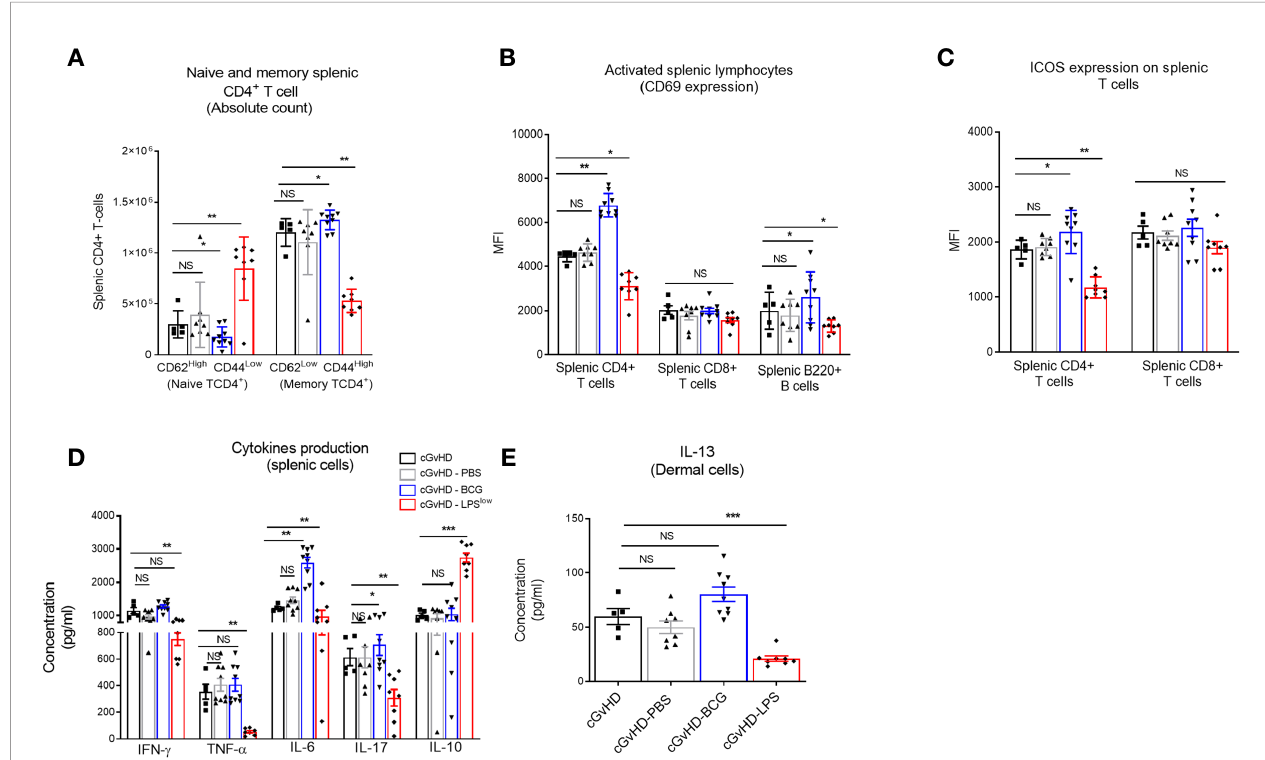
FIGURE 3 | Trained macrophage infusion affects the activation and the cytokine production of splenic immune cells in cGvHD mice. (A) Frequency of naive and memory CD4 + T-cell subpopulations in the spleen of the different experimental groups. Data represent absolute count of naive (CD62L High CD44 Low ) and memory (CD62L Low and CD44 High ) CD4 + T cells among the total splenic CD4 + T-cell population ± SEM obtained from at least n = 7 biologically independent mice. (B, C) Activation of splenic CD4 + , CD8 + T cells and B220 + B cells assessed by fl ow cytometric measurement of the CD69 expression (B) and ICOS expression for the T-cell subpopulations (C) . Data represent the MFI ± SEM from at least n = 7 biologically independent mice. (D) Cytokine production in the supernatant of stimulated splenic cells. Spleen cell suspensions were stimulated with 5 m gml − 1 of Concanavalin A and incubated for 48 h at 37°C with 5% CO 2 . Levels of IFN- g , TNF- a , IL-6, IL-17, and IL-10 were assessed by ELISA, and concentrations are expressed in pg/ml. Data represent the mean ± SEM from the duplicate of at least n = 7 biologically independent samples. (E) ELISA assessment of IL-13 production (pg/ml) by skin-derived immune cells. Each box represents mean ± SEM of triplicate obtained with cell culture from at least n = 7 biologically independent mice. NS, Non-signi fi cant; *p ≤ 0.05; **p ≤ 0.01; ***p ≤